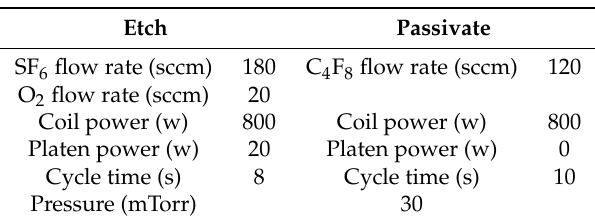
Table 3. Optimal Parameters of DRIE.